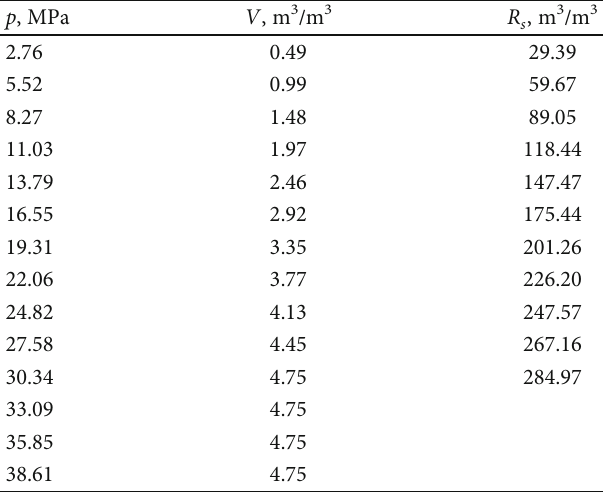
Table 4: Adsorbed gas volume and dissolved gas-oil ratio in